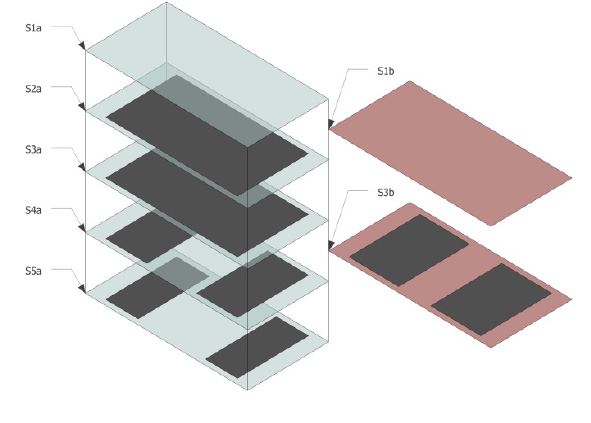
Figure 5. Concept of slicing threshold